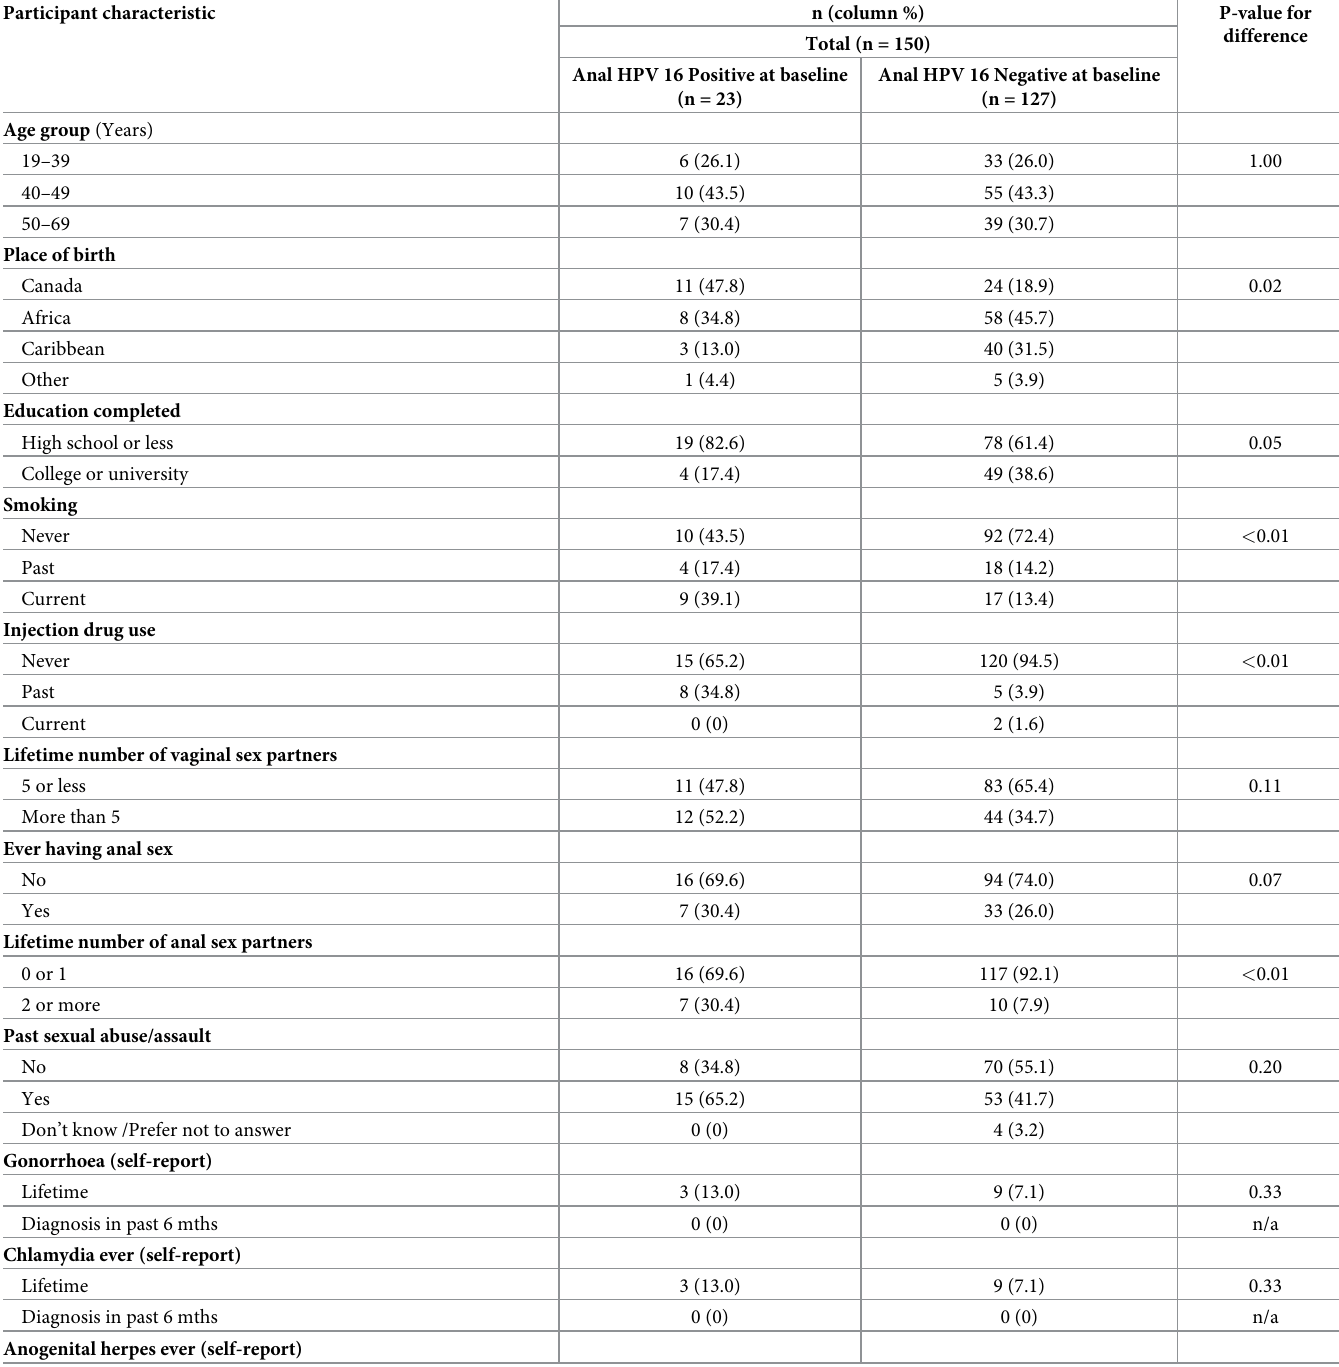
Table 1. Baseline characteristics of 150 women living with HIV, by anal HPV 16